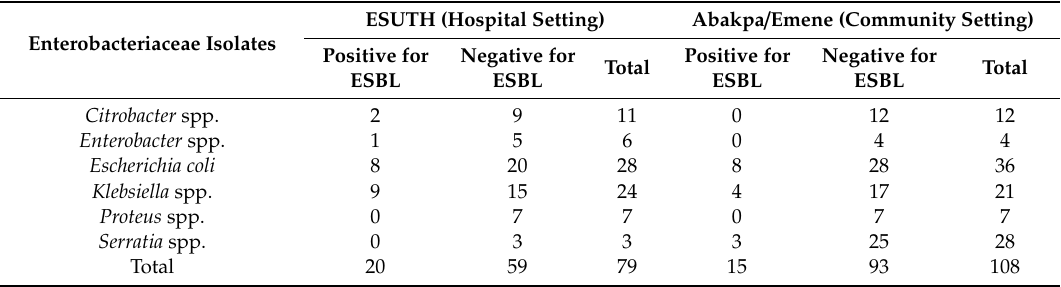
Table 2. Extended-spectrum β -lactamase (ESBL) confirmatory testing of the Enterobacteriaceae